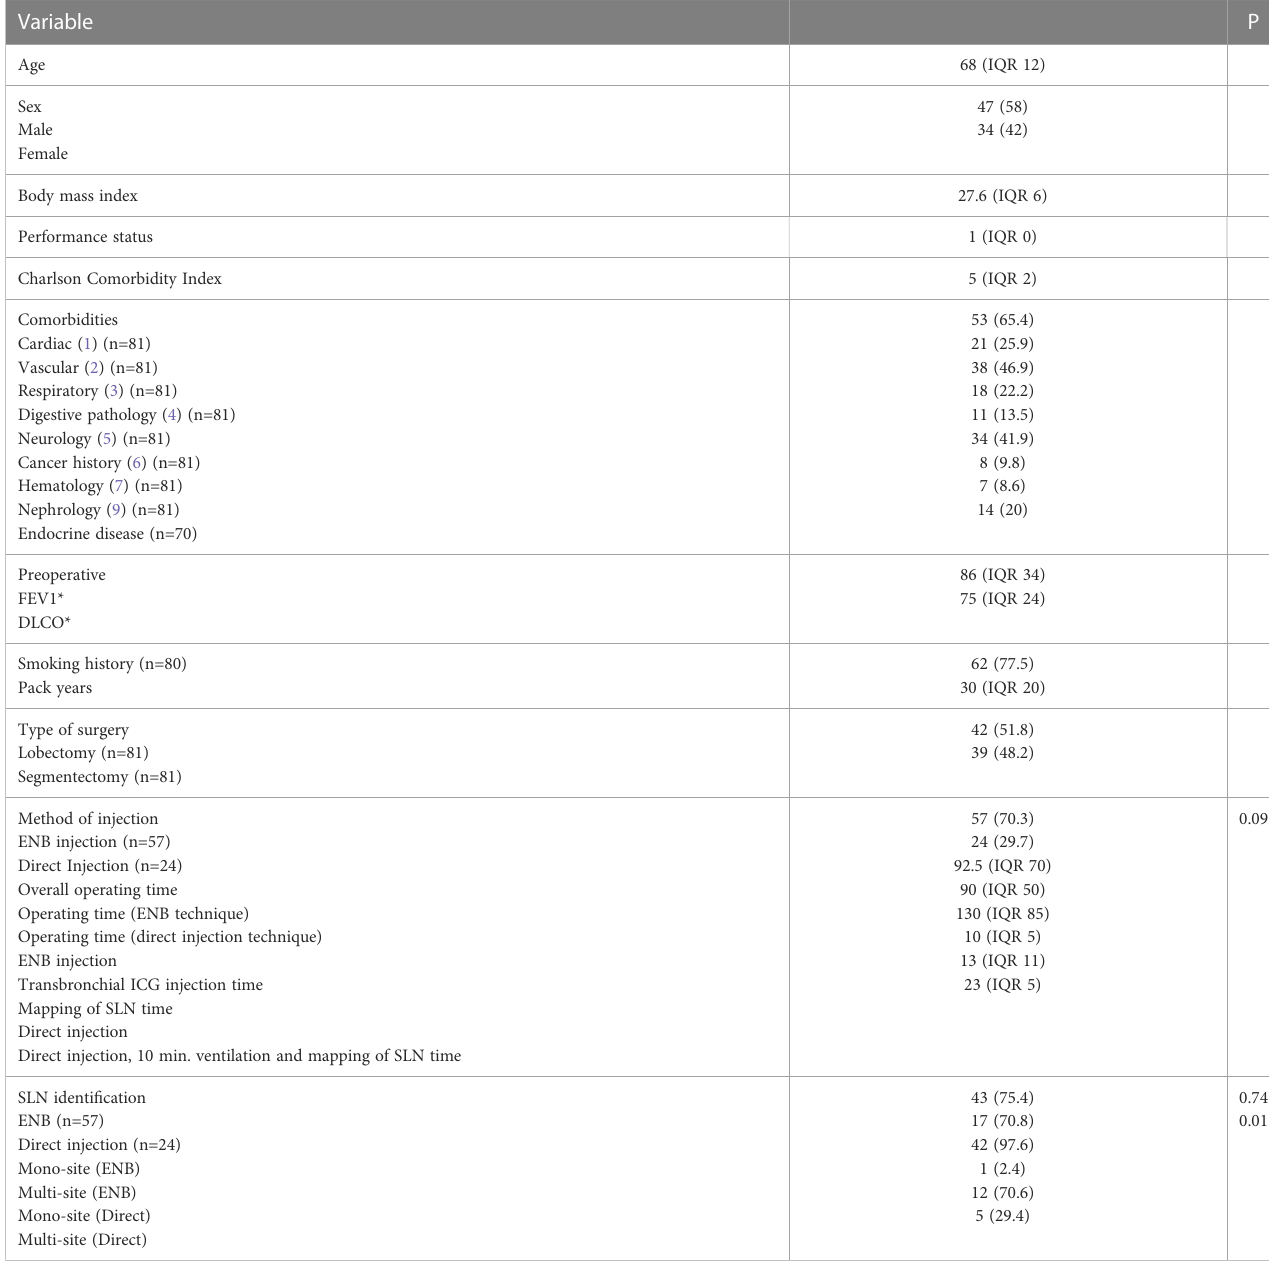
TABLE 1 Patients characteristics (n=81).